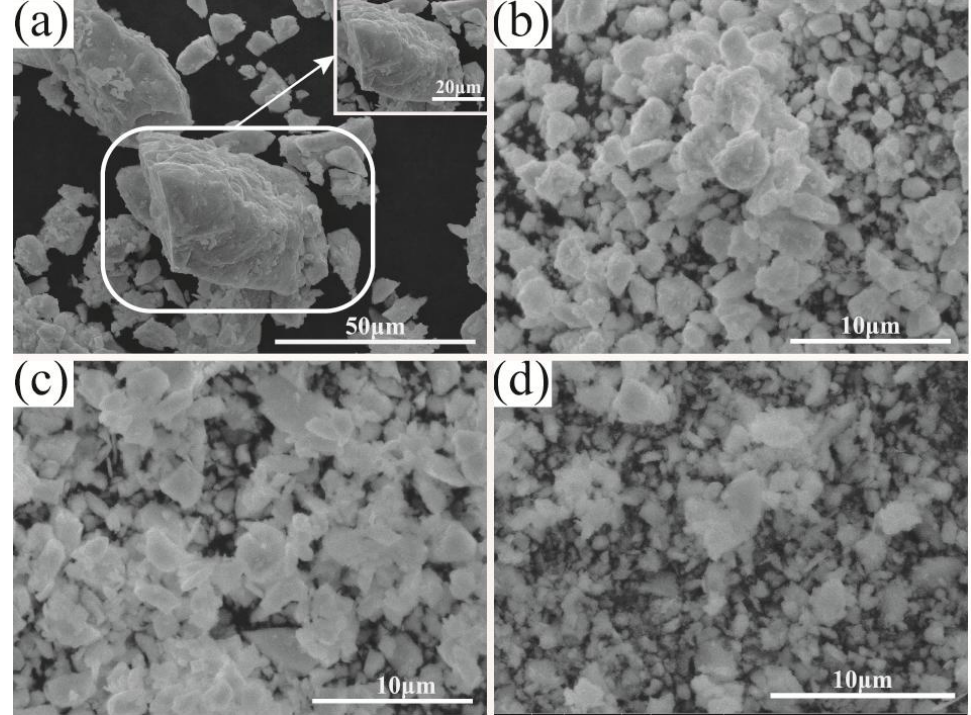
Figure 4. Scanning electron microscopy (SEM) images of ( a ) Crushed Mn 55 Bi 45 powders and Mn 55 Bi 45 powders obtained by SALEBM at ( b ) 4 h, ( c ) 10 h, ( d ) 14